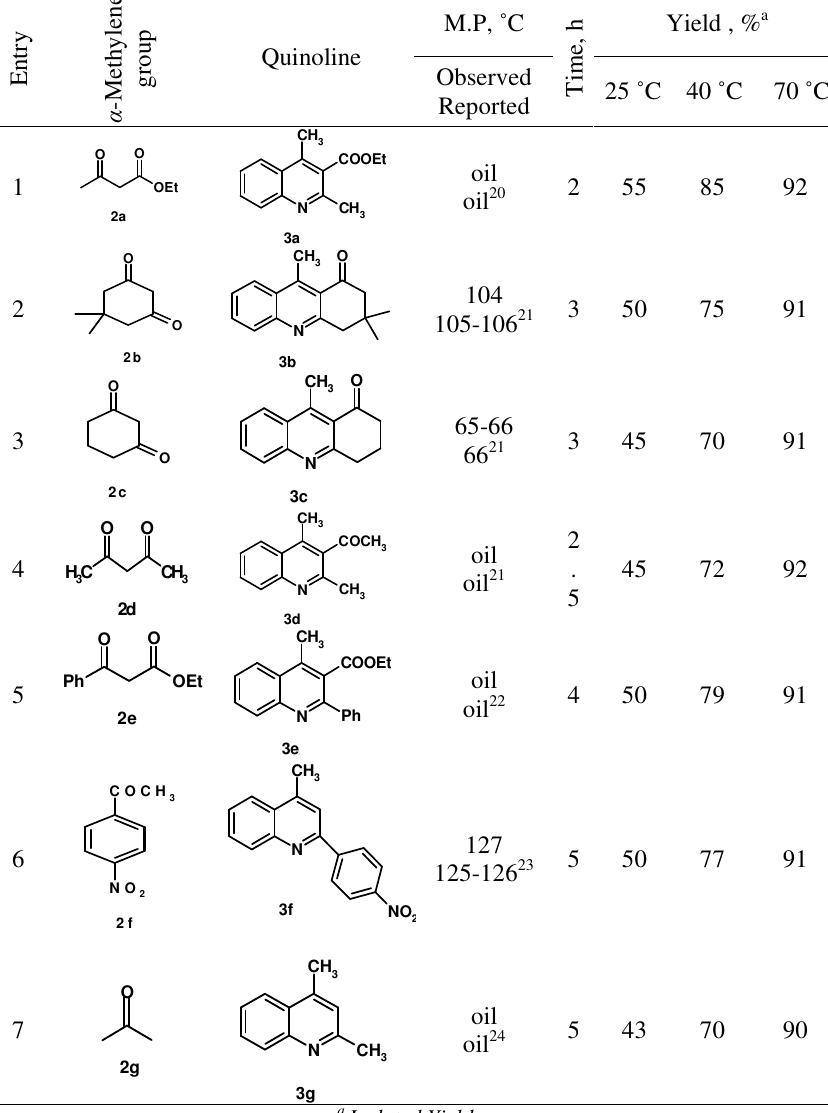
[P W O ] catalyzed synthesis of Friedländer Quionlines. 6 2 18 62